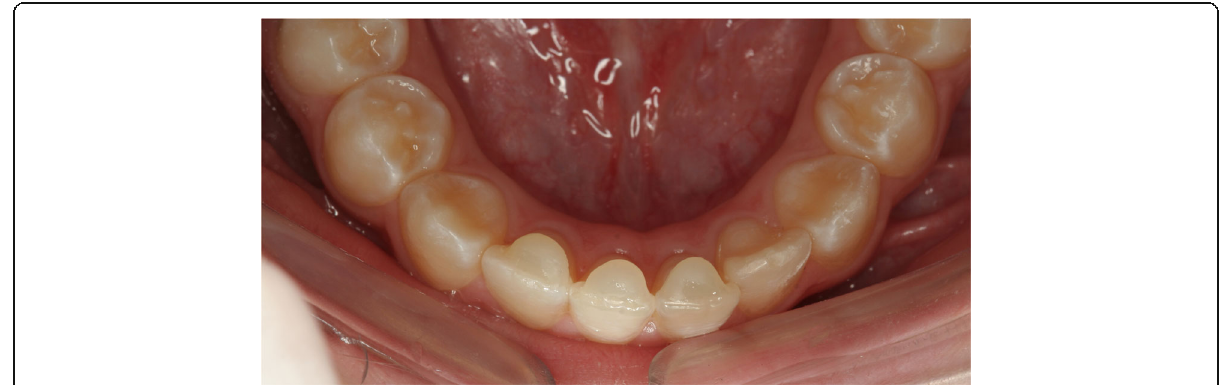
Fig. 2 To elevate the bite, stops made of flow resin were inserted on the mandibular